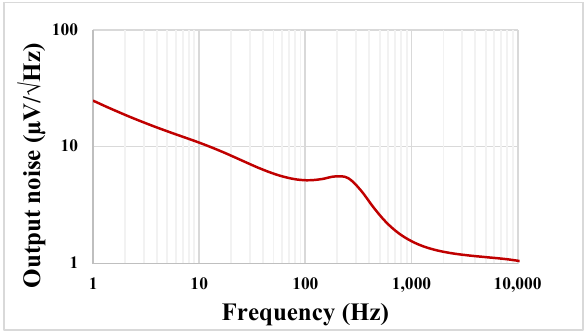
Figure 12. The transient response of the LP filter.